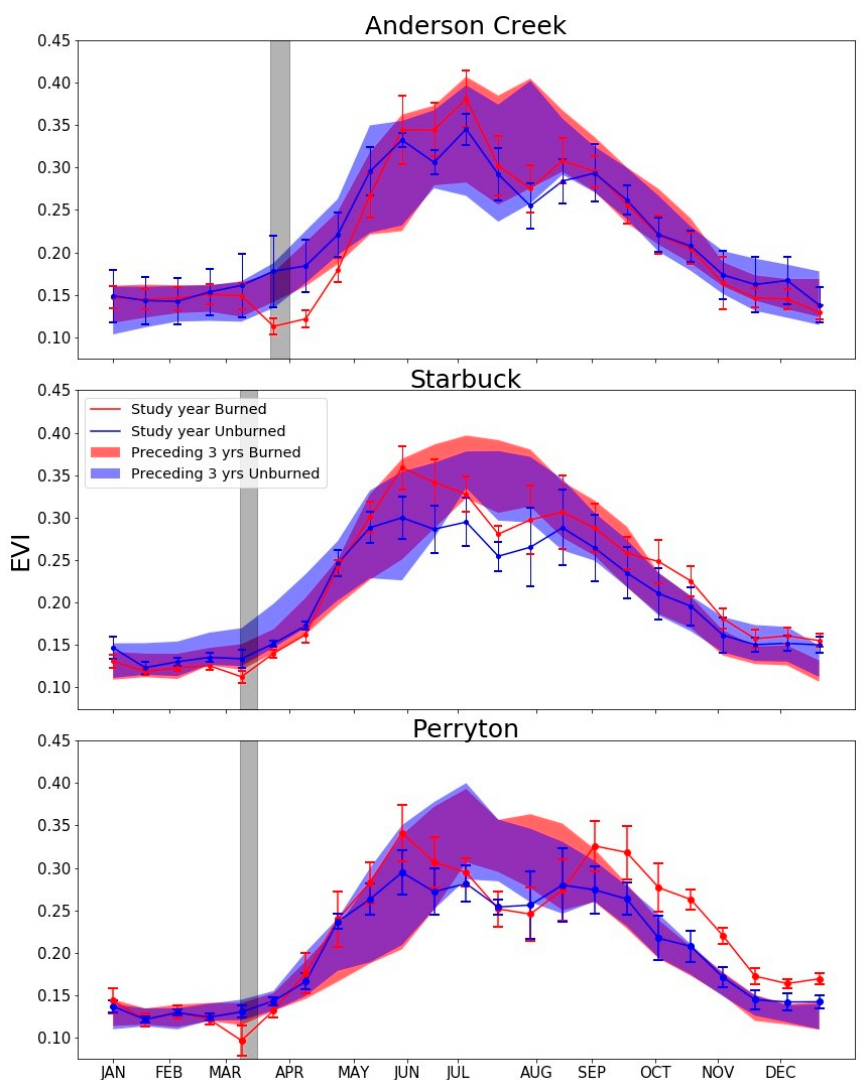
Figure 3. Three year average Enhanced Vegetation Index (EVI) values for the unburned plots (blue shaded) and burned plots (red shaded) of the Anderson Creek (top), Starbuck (middle), and Perryton (bottom) wildfires. Fire year EVI averages for the unburned (blue) and burned (red) plots are shown as solid lines with error bars of one standard deviation. Time of fire is marked by grey shaded columns.